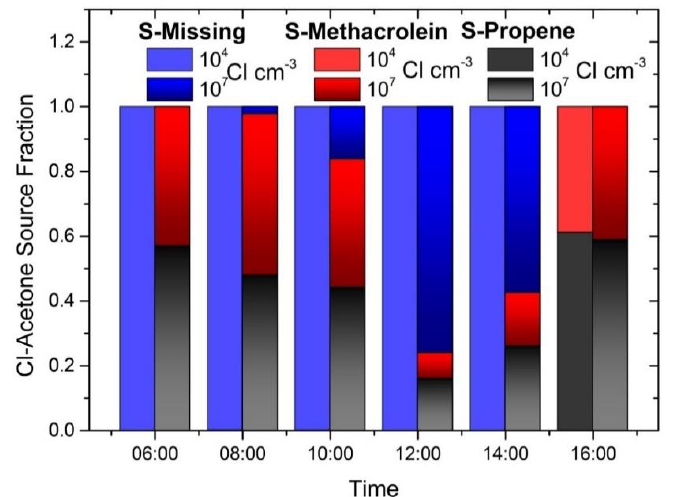
Figure 5. Source fractions contributing to the chloroacetone formation at 10 4 Cl atoms cm −3 (left bright bars) and 10 7 Cl atoms cm −3 (right lighter bars) for Lake Boats. The Br concentration was fixed at 10 8 cm −3 .